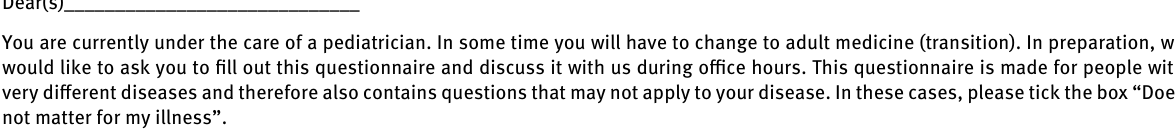
Table 1: Questionnaire for the preparation of transfer from the center for child and adolescent medicine to adult care (modified according to refs.